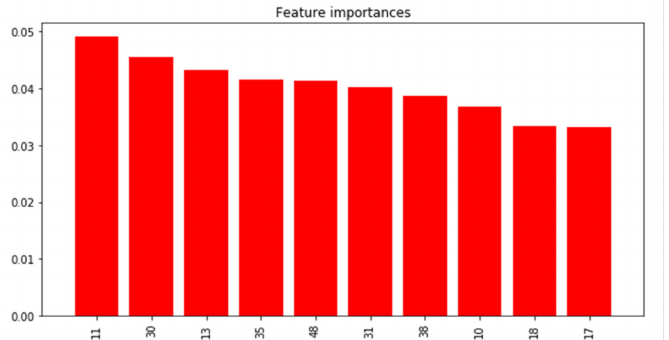
Figure 10. Feature importance for top-10 W-TSS shapelets in predicting indoor vs. outdoor time series PM 2.5 in PRISMS.